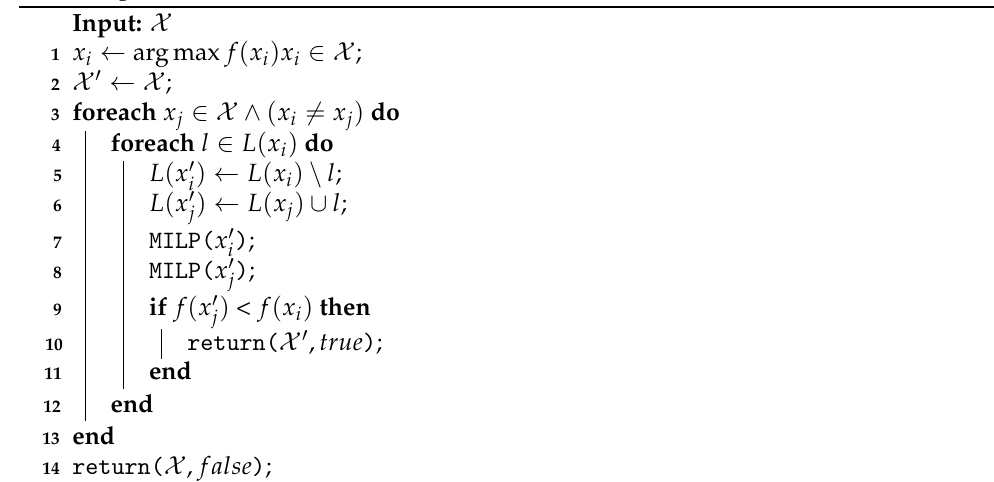
Algorithm 6: Shift neighborhood function performed on exact method for routing